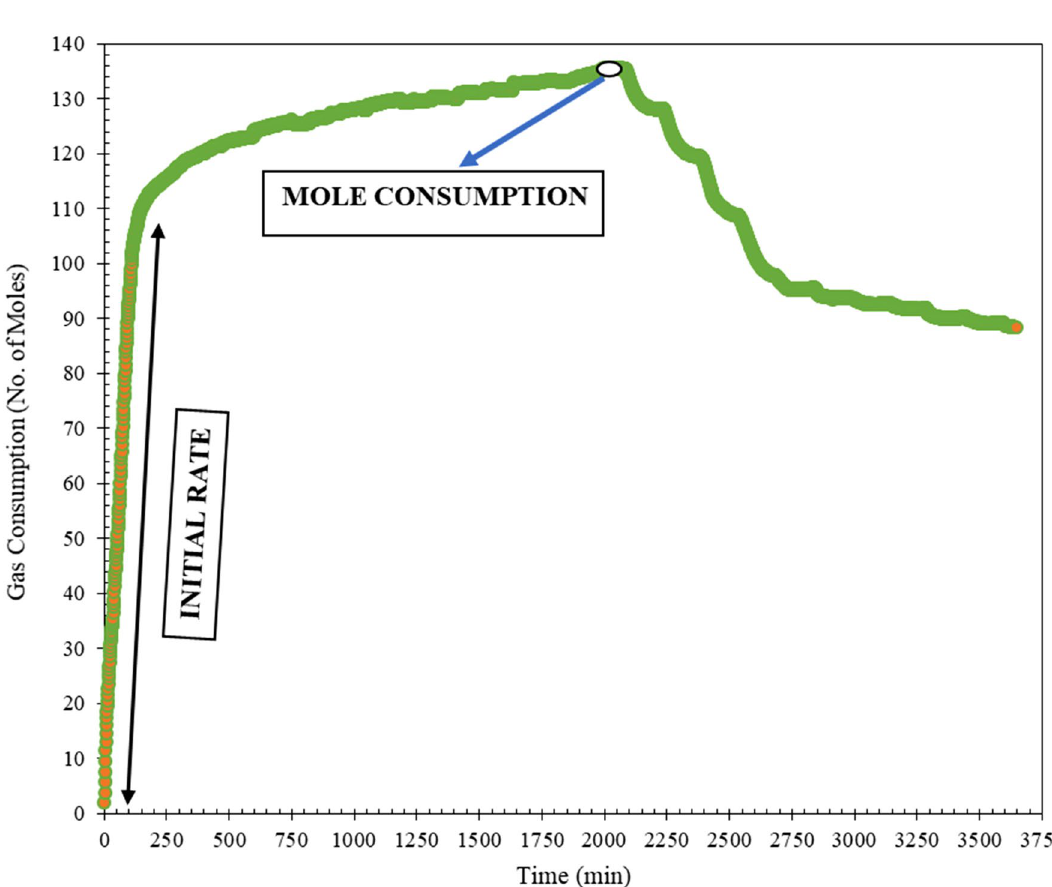
Figure 5. Gas consumption (CO 2 ) curve vs. time ( t